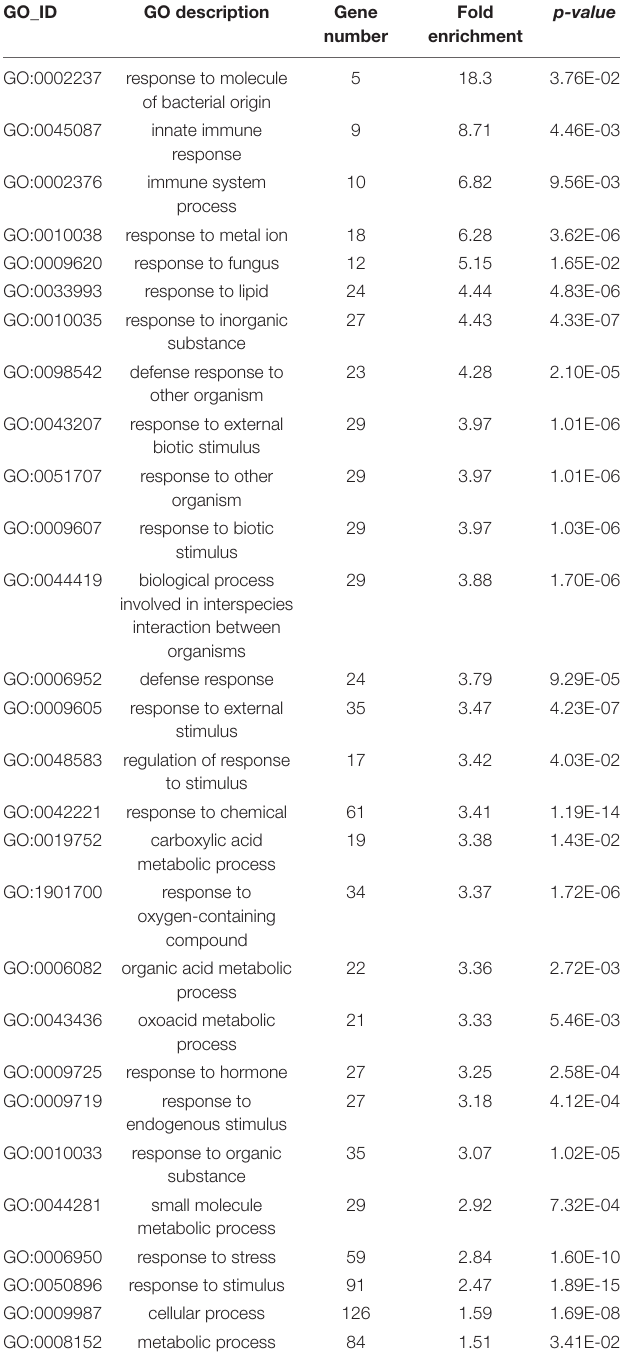
TABLE 1 | GO enrichment analysis of Biological process of the 214 common upregulated genes in eca2 , bdg and lacs2-3 infected with Botrytis cinerea (genes are listed in Supplementary Data 6